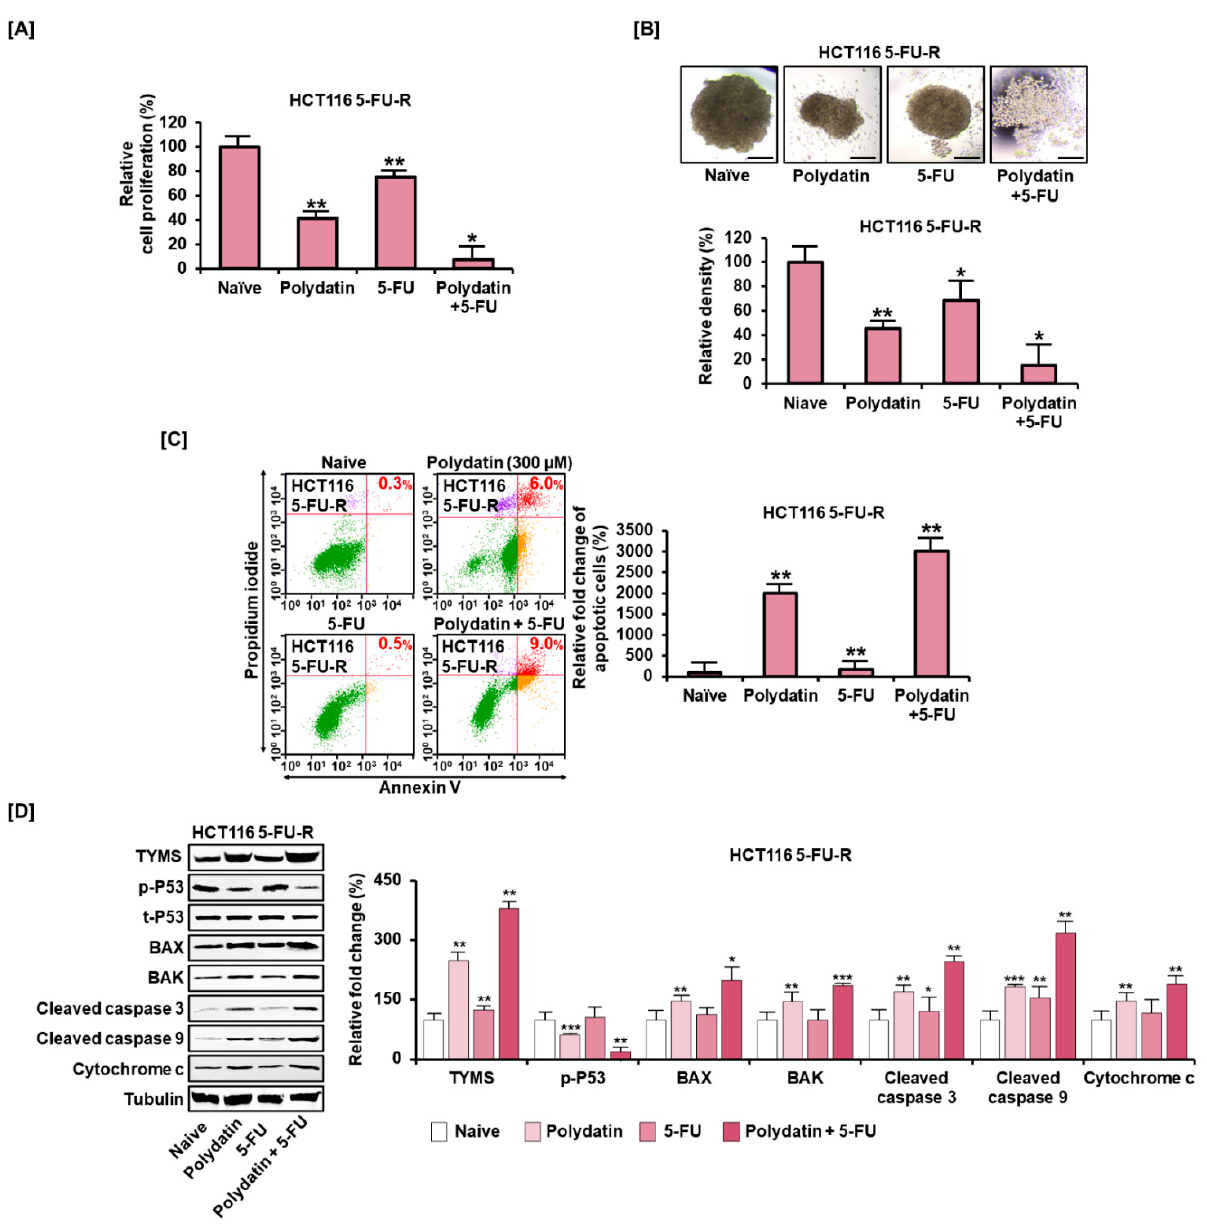
Figure 7. The potency of polydatin to assuage resistance of 5-FU in colon cancer cells. ( A ) Antiproliferative effect of polydatin in 5-FU-R cells with or without 5-FU. ( B ) Effect of 72-h treatment with a combination of polydatin and 5-FU on spheroids formation in 5-FU-R cells. Scale bar: 100 µ m. ( C ) Apoptotic effect of polydatin in 5-FU-R cells with or without 5-FU, as elucidated by Annexin V and PI staining. ( D ) In 5-FU-R cells, effects of polydatin on the protein expression of TYMS and apoptosis-related factors with or without 5-FU, as determined by Western blotting. The asterisks symbolize significant differences among various groups (* p < 0.05, ** p < 0.01, and *** p < 0.001).